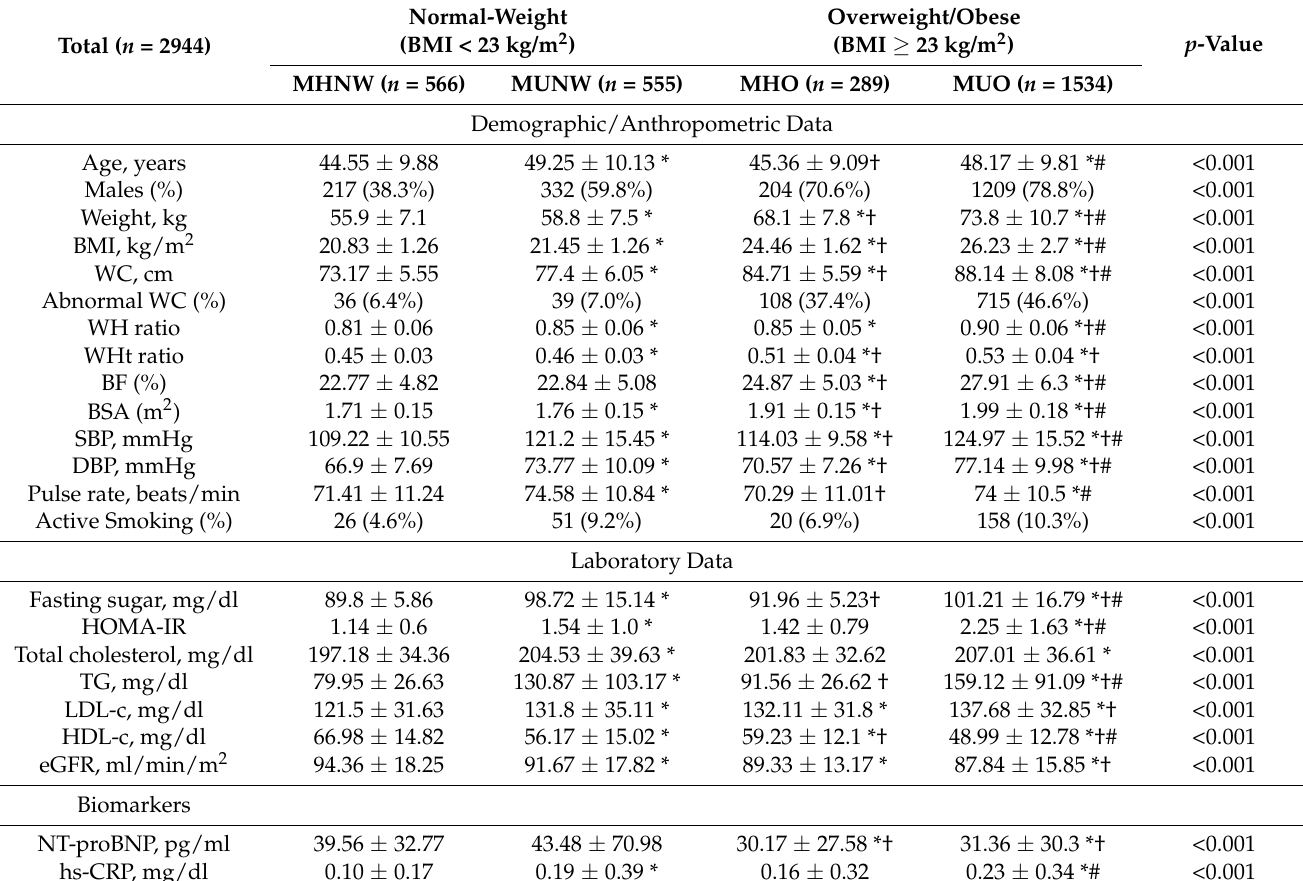
Table 1. Baseline demographics and laboratory information of study participants according to obesity phenotypes.